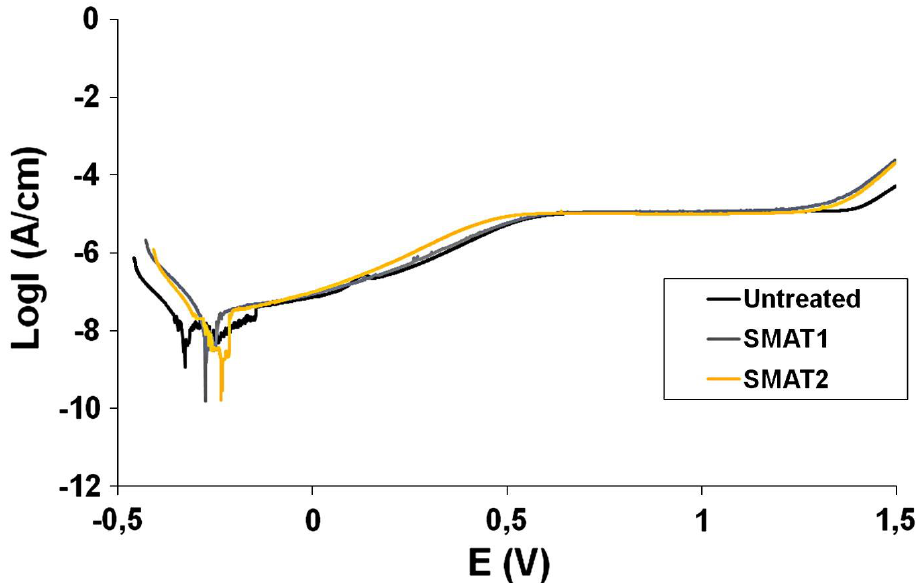
Figure 5. The enhanced corrosion resistance of Ti implants modified with surface mechanical attrition treatment (SMAT). The potentiodynamic polarization curves reveal that SMAT signifi- cantly increased the corrosion potential (E corr ) while decreasing Ti implants’ corrosion current (I corr ), enhancing their corrosion resistance. Reproduced with permission from [77].